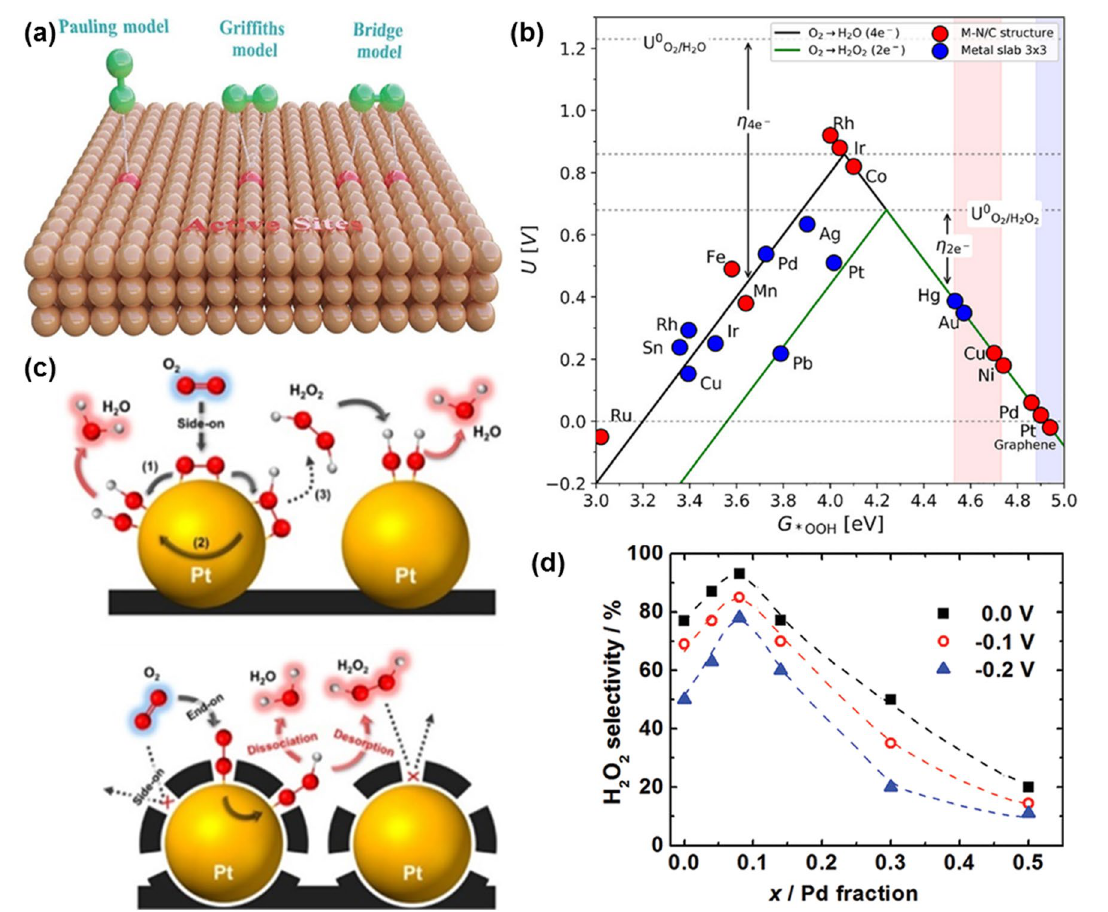
Fig. 12 a Three typical modes for O 2 adsorption. Reproduced with permission from Ref. [192]. Copyright 2021 Elsevier . b Sabatier volcano plots for electrochemical ORR for pure metal slabs and M–N/C. Reproduced with permission from Ref. [193]. Copyright 2018 American Chem- ical Society. c Proposed ORR pathways on the pristine Pt/C and carbon-coated Pt electrocatalysts. Reproduced with permission from Ref. [200]. Copyright 2014 American Chemical Society. d H 2 O 2 selectivity of the Au 1-x Pd x electrocatalyst with different palladium contents at potentials of 0, -0.1 and -0.2 V. Reproduced with permission from Ref. [208]. Copyright 2011 American Chemical